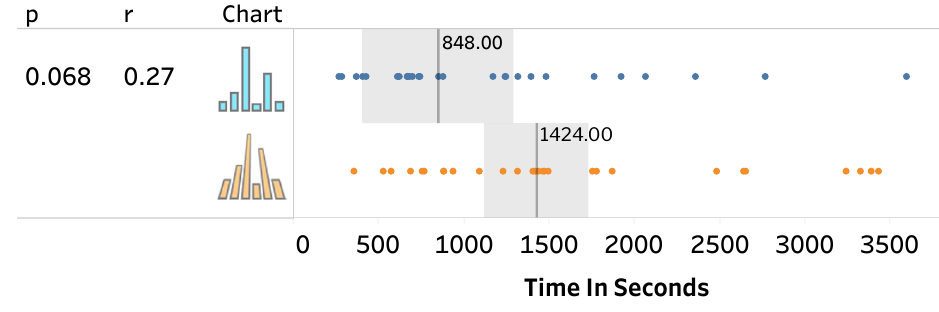
Figure 7. Task completion time for both techniques. The central bar inside the grey box represents the median task time. The p -value and effect size (r) of each task type is shown in the table. Each grey box denotes the 95% confidence interval of the median. Each dot represents the HIT completion time in seconds for an individual participant.